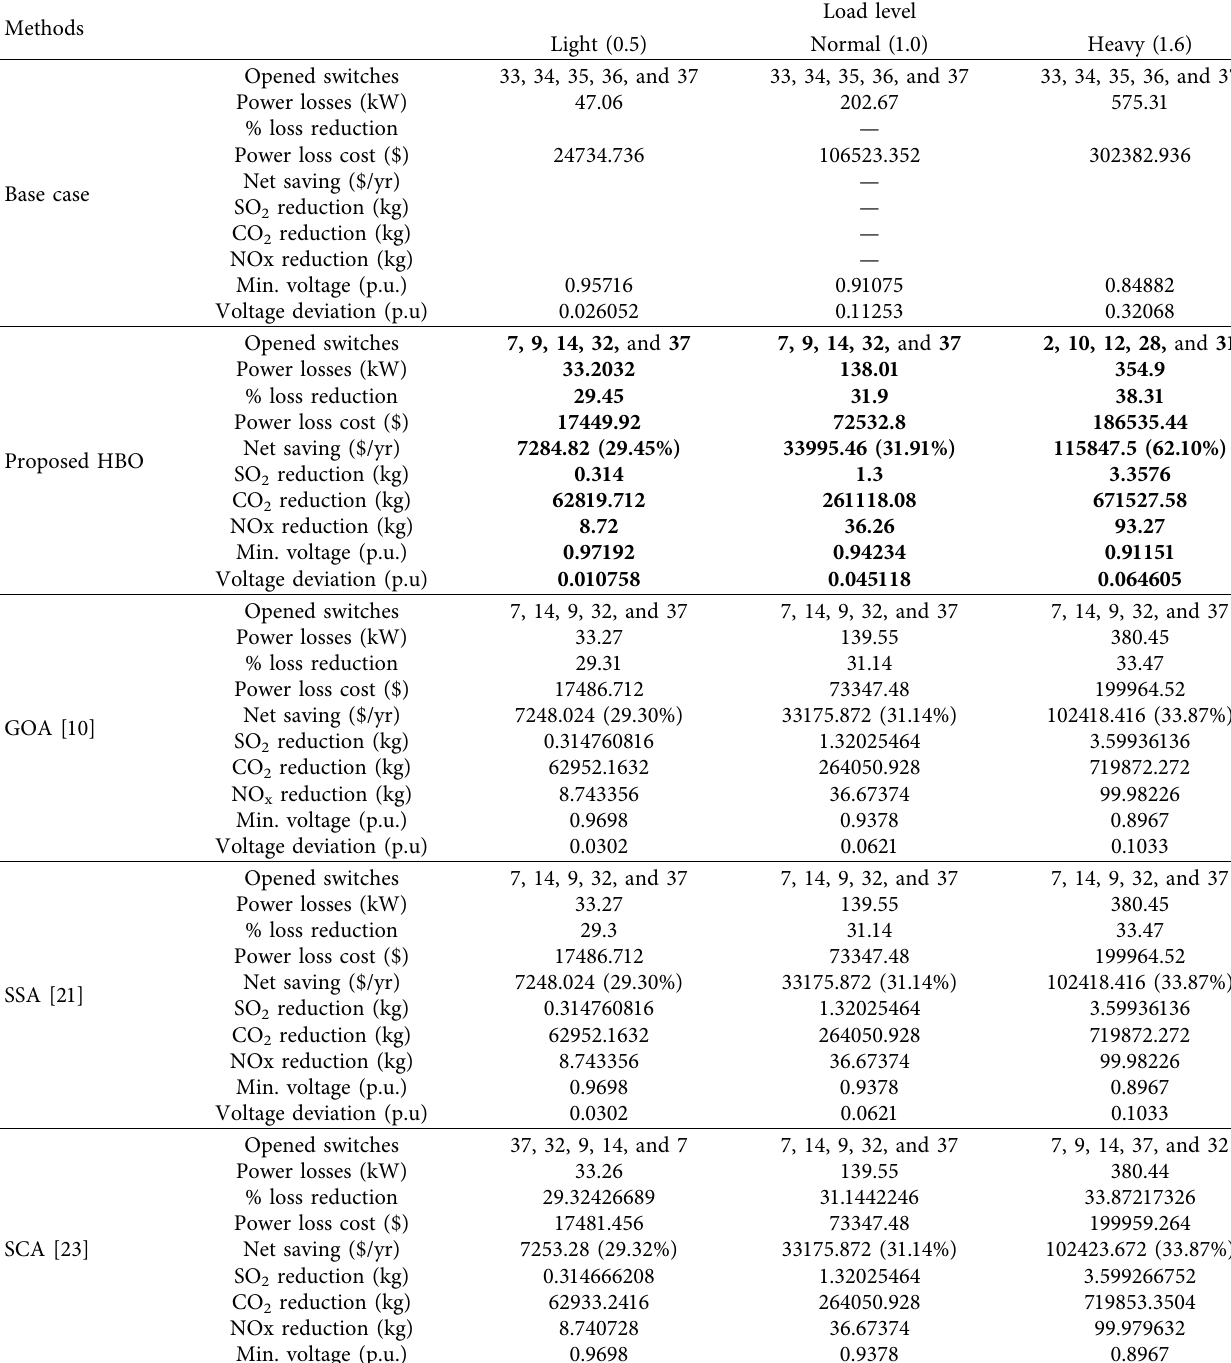
Table 5: Performance analysis of proposed HBO on 33-bus system for diferent studied cases under diferent load levels.